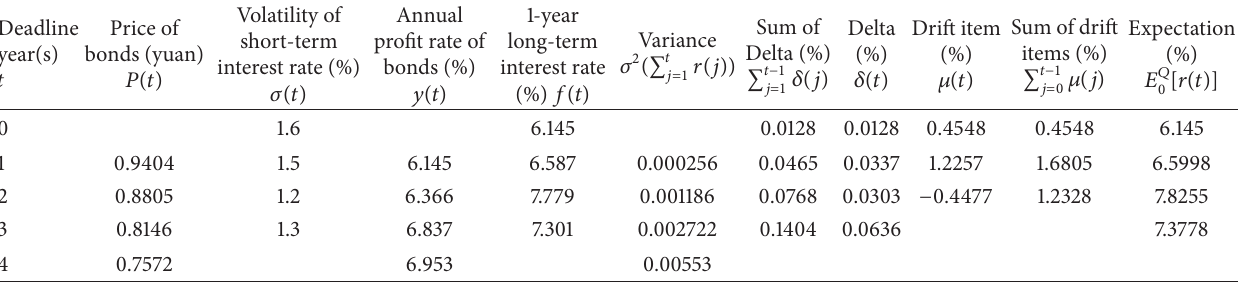
Table 2: Time-varying volatility interest rate parameters.